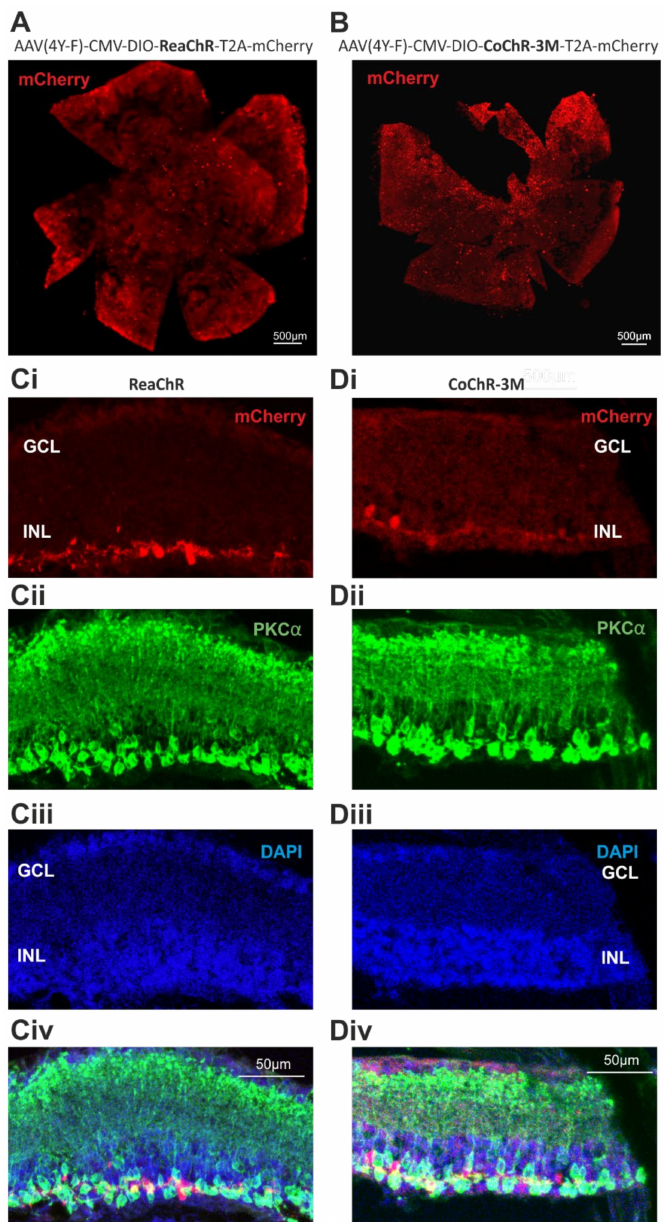
Figure 4. Characterisation of a Grm6 Cre rd1 mouse treated with channelrhodopsins: ReaChR and CoChR- 3M. ( A , B ) Representative retinal wholemount images of Grm6 Cre rd1/rd1 mice following intravitreal injection of ReaChR in ( A ) and CoChR-3M in ( B ), displaying widespread transduction of the mCherry reporter. ( C ( i – iv ), D ( i – iv )) Retinal cross sections of Grm6 Cre rd1/rd1 mice following intravitreal injection of ReaChR and CoChR-3M in ( B ) displaying mCherry co-localisation within PKC α -expressing bipolar cells: ReaChR and CoChR-3M. ( C ( i ), D ( i )) mCherry (in red); ( C ( ii ), D ( ii )) PKC α (in green) and ( C ( iii ), D ( iii )) DAPI (in blue), ( C ( iv ), D ( iv )) represent merge of corresponding images. ONL = outer nuclear layer; INL = inner nuclear layer; GCL = ganglion cell